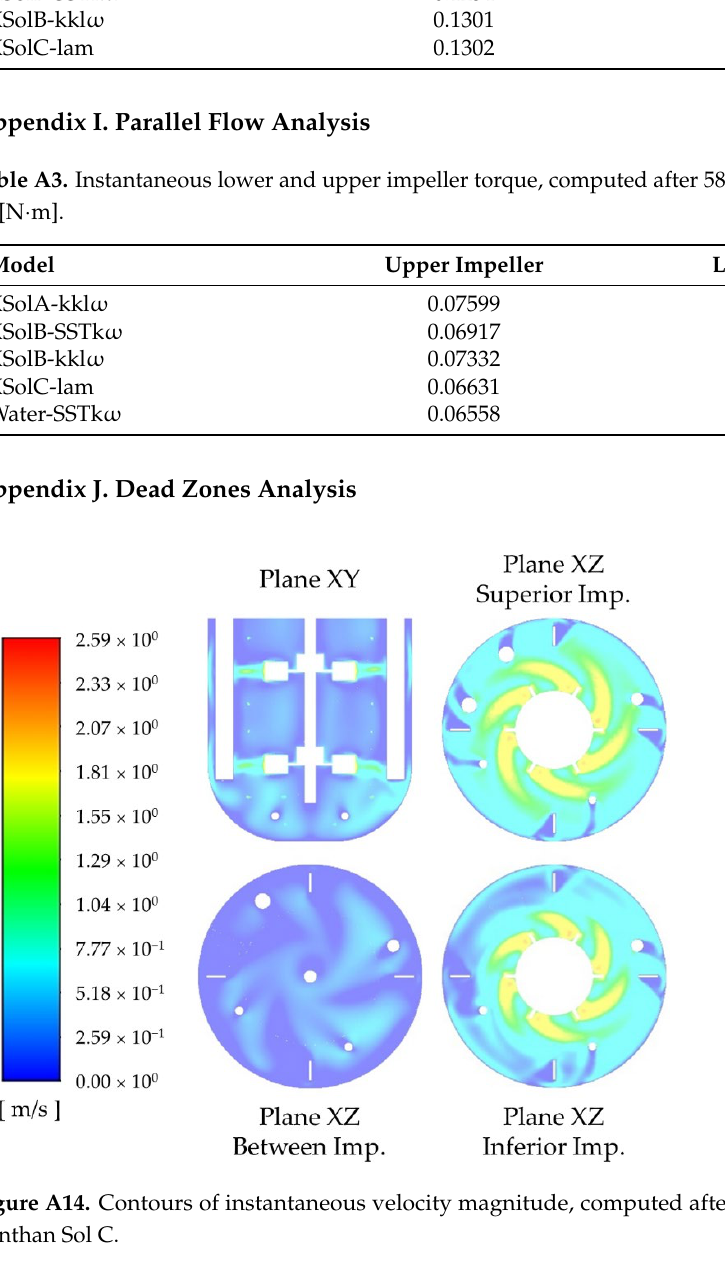
Figure A15. Analysis of velocity magnitude distribution for the quantification of dead zones vol- ume, when the system evolves ( a ) from water to Xanthan Sol B and Xanthan Sol A, and ( b ) from water to Xanthan Sol C.